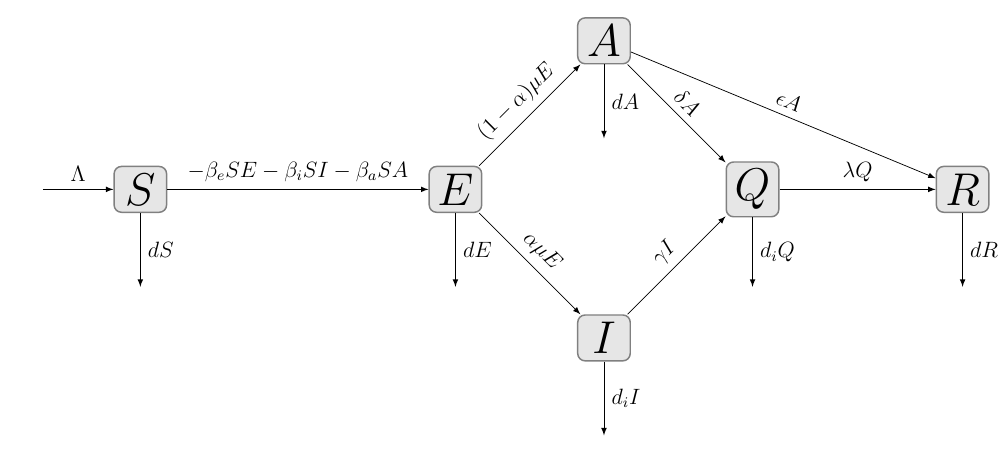
Figure 1. The graphical illustration of the SEIAQR